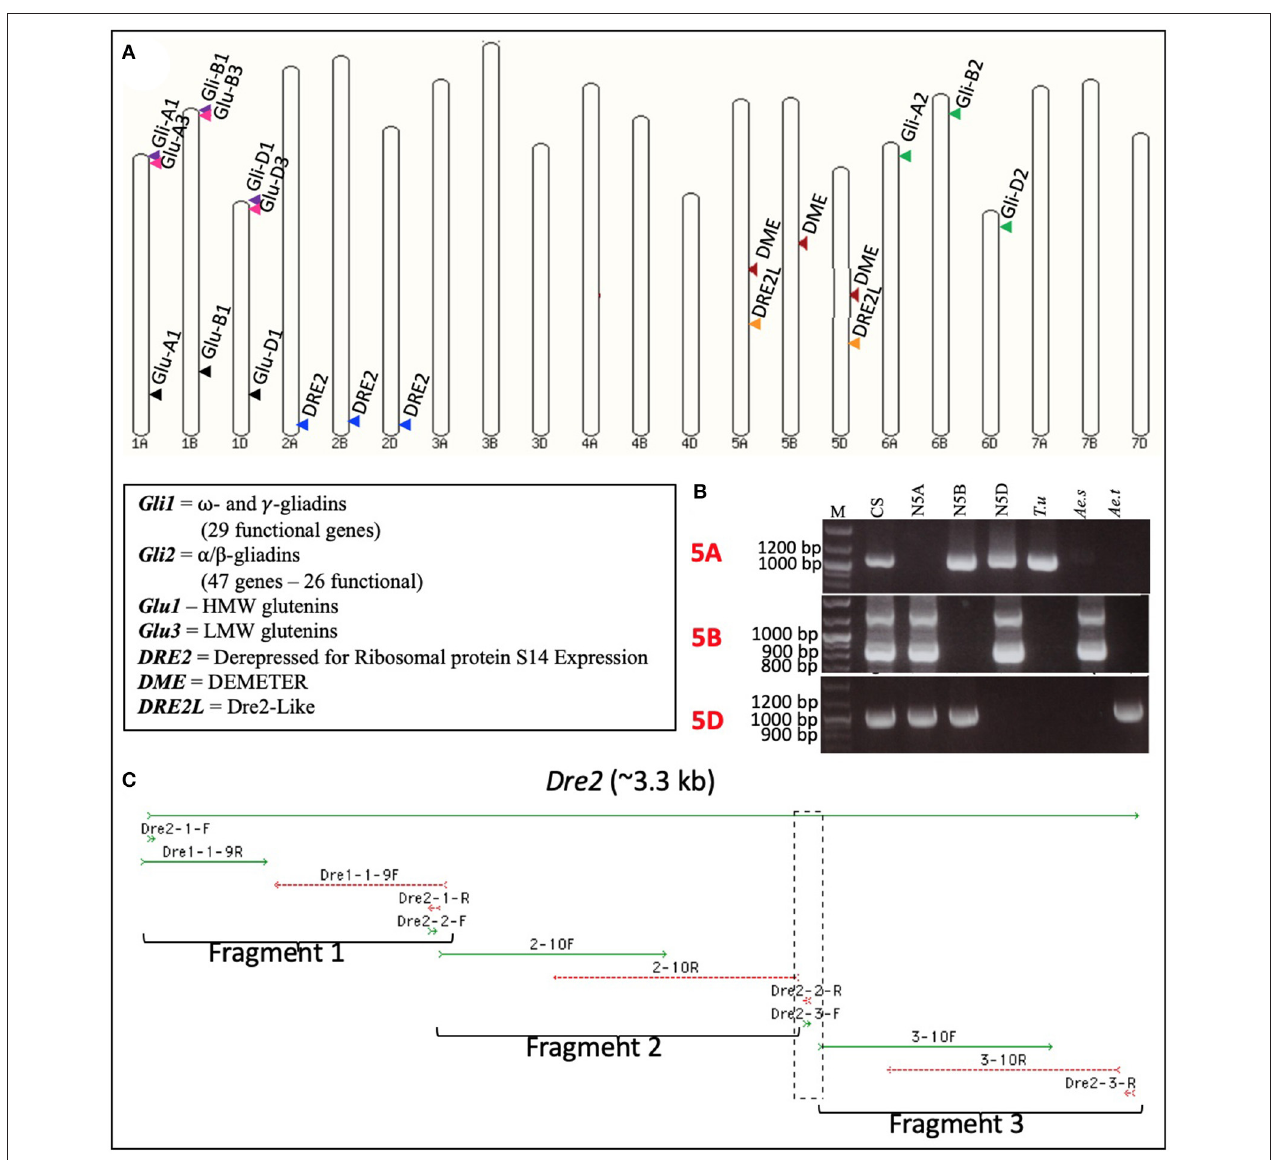
FIGURE 1 | Subgenome and chromosome locations of wheat DEMETER ( DME ), DRE2 , and DRE2L genes. Diagrammatic representation of the locations of the wheat DEMETER ( DME ), DRE2 , DRE2L , and prolamin genes on wheat pseudochromosomes. (A) Gene locations were marked via arrowheads, and homoeologous genes were shown in similar colors. PCR amplification profiles obtained using the wheat DME homoeologues-specific primers ( Supplementary Table S1 ) on the genomic DNA of wheat diploid progenitors - Triticum urartu ( T.u ), Aegilops speltoides ( Ae.s ), and Aegilops tauschii ( Ae.t ) - wheat nullisomic tetrasomic (NT) lines [group 5 chromosomes – null 5A (N5A), null 5B (N5B), and null 5D (N5D)] and the common wheat cultivar “Chinese Spring” (CS). (B) Notice the absence of bands in the NT lines and their presence in the corresponding subgenome. It confirms the presence of a gene in a certain wheat subgenome and a chromosome; M = molecular weight marker. Full-length sequence of the wheat DRE2 homoeologues obtained using a stepwise cloning procedure (C) .